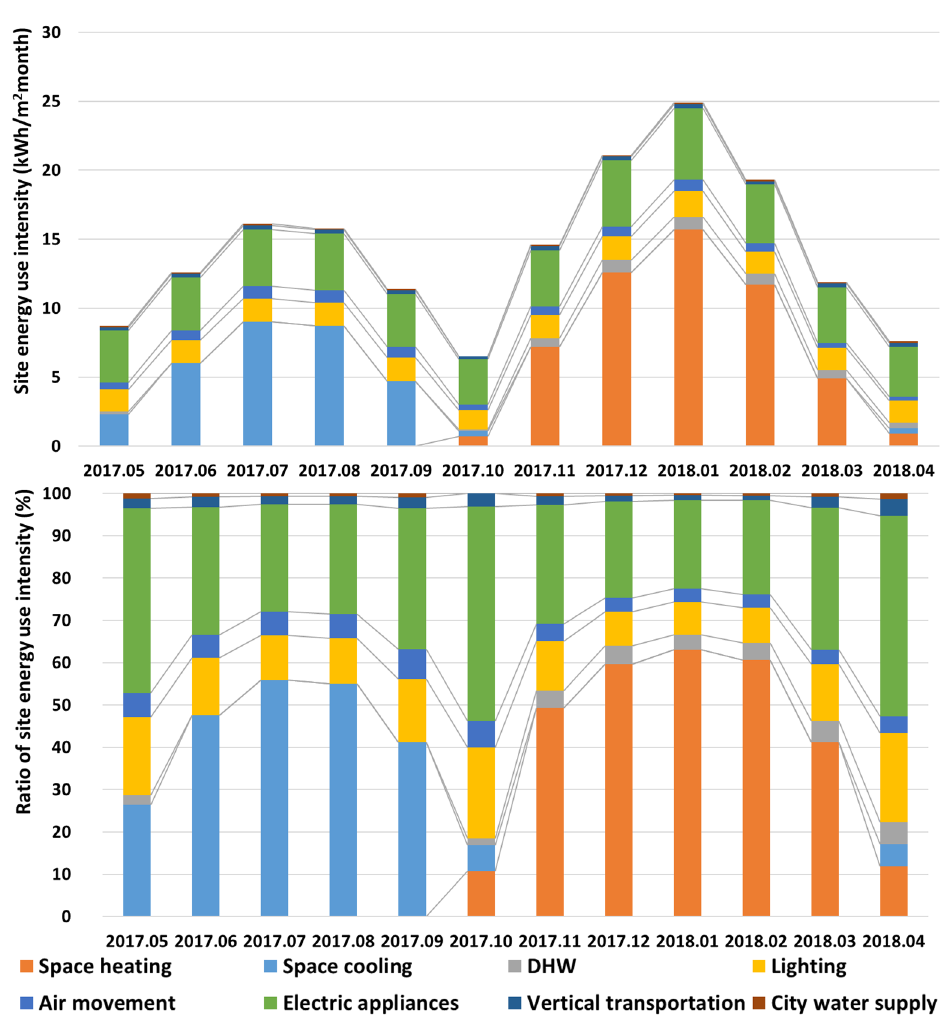
Figure 2. Monthly average site EUI distribution (kWh/m 2 ·month) and ratios (%).